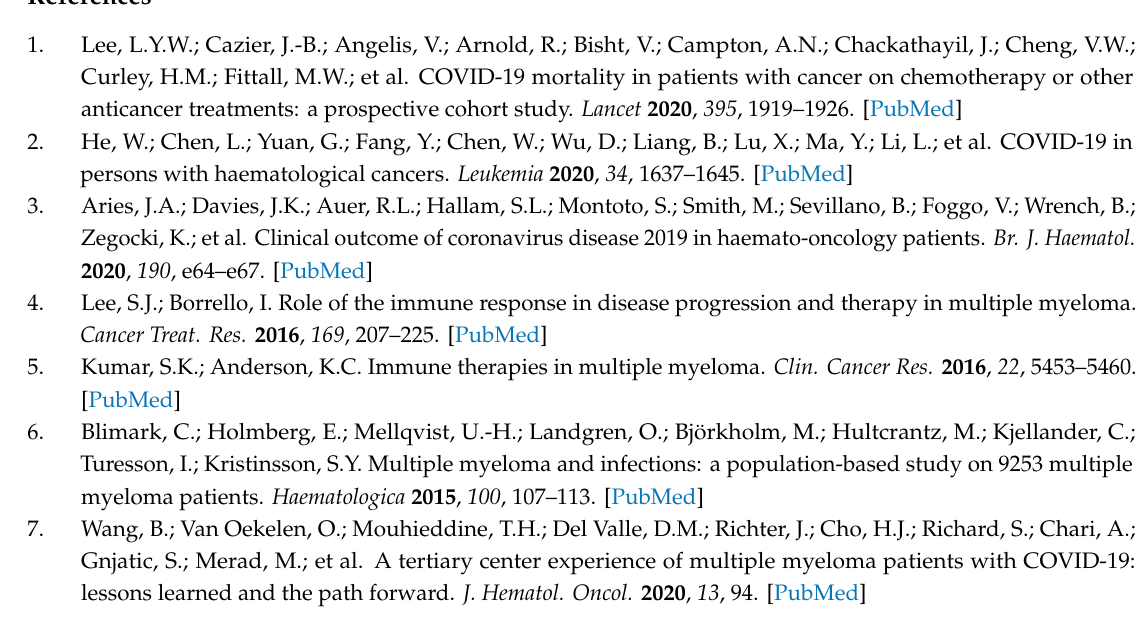
Table S1: Summary of the serology assays included, Table S2: Clinical characteristics of patients included in this study, Table S3: Clinical characteristics of patients with hematologic malignancies who were positive for SARS-CoV-2 infection by